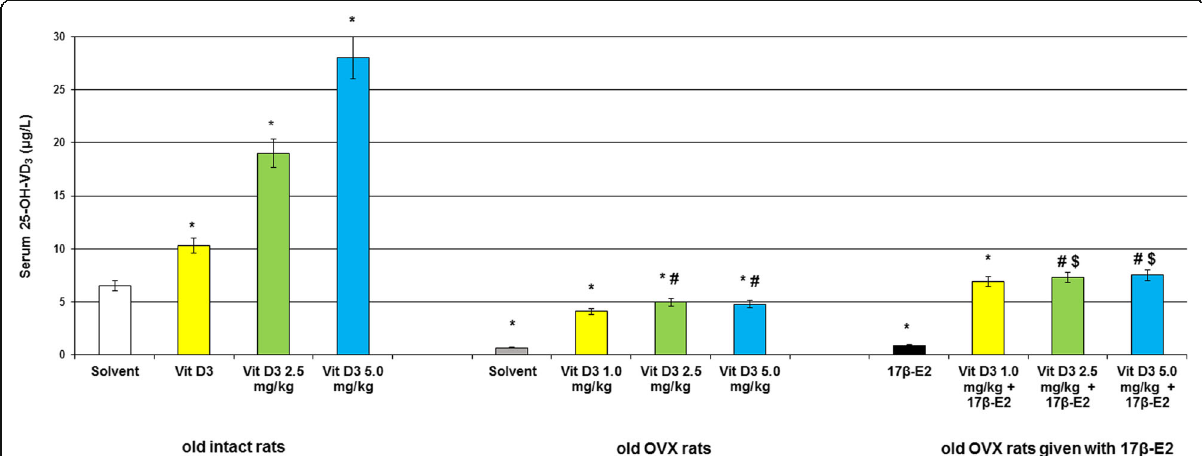
Fig. 4 Effects of Vitamin D 3 administration on 25-OH-VD 3 level of the old ovariectomized (OVX) rats following long-term estrogen deficiency in the serum blood. The obtained results show the mean ± standard error of the mean (SEM). * – p < 0.05 as compared to the control group of the old sham-operated rats; # – p < 0.05 as compared to the old OVX rats treated with solvent; $ – p < 0.05 as compared to the old OVX rats treated with 17 β -estradiol (17 β -E 2 ). Each group comprised a minimum of eight rats. Cholecalciferol was given at 1.0, 2.5 or 5.0 mg/kg/daysubcutaneously (s.c.), once daily, for 14 days. The administered dose of 17 β -estradiol was 0.5 μ g/rat s.c., once daily, for 14 days